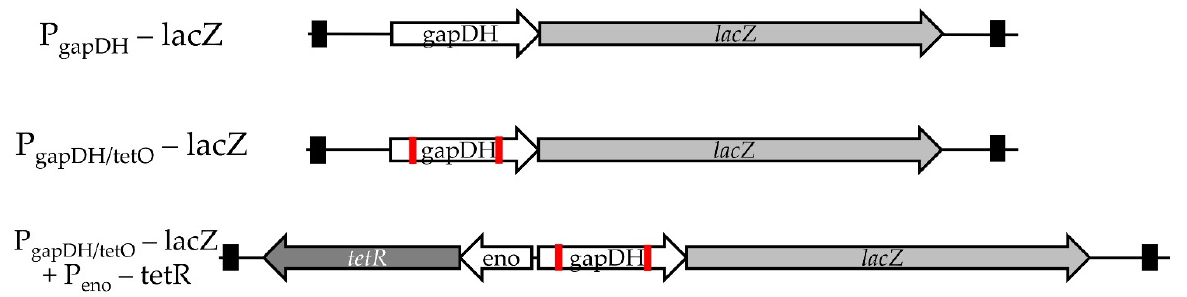
Figure 5. The schematics of each construct made to test the aTc inducible system. P gapDH — lacZ is the starting point: the P gapDH promoter driving the expression of lacZ (plasmid pAL66). P gapDH/ tetO — lacZ represents the insertion of a tetO1 box into each − 35/ − 10 region of the gapDH promoter (pAL88). P gapDH/ tetO — lacZ + P eno — tetR represents the addition of the tetR gene driven by P eno in the opposite orientation to the P gapDH/ tetO — lacZ gene (pAL111). White arrow boxes represent promoter sequences, while gray arrow boxes are open reading frames. Solid red boxes represent the tetO1 boxes. Solid black boxes represent the terminators present at either end of the MCS in plasmid pMTL86251. The tetR gene was amplified from E. coli and placed behind the next strongest clos-